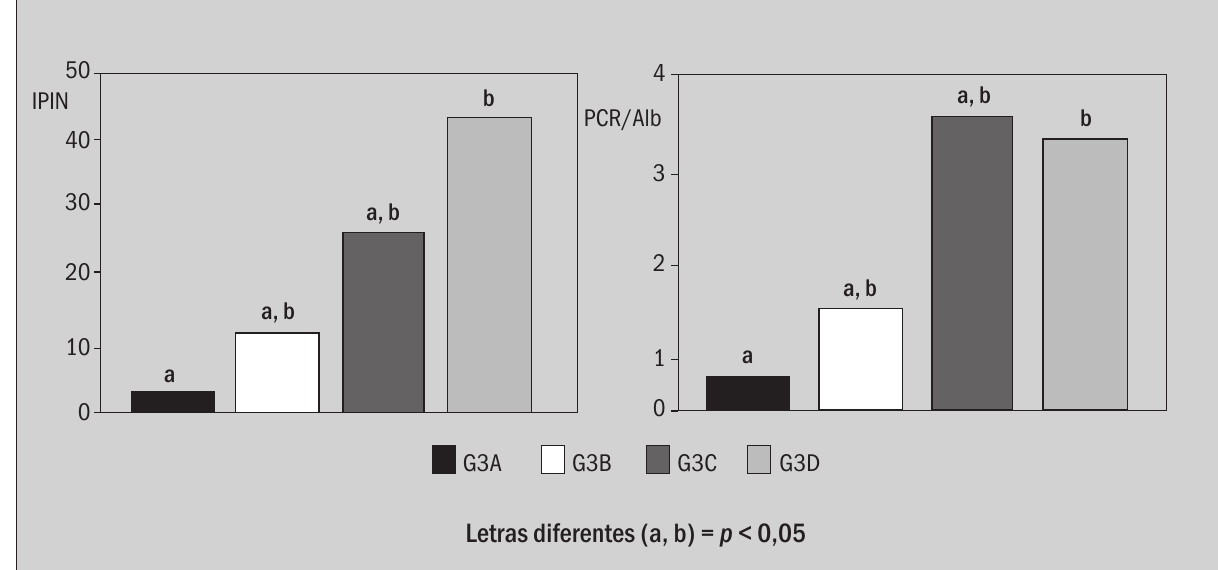
Figura – Valores da mediana dos índices prognóstico inflamatório e nutricional (IPIN) e proteína C reativa/albumina (PCR/Alb) dos pacientes com vários graus de risco de morbimortalidade (G3A = baixo risco; G3B = médio risco; G3C = alto risco; G3D = risco de